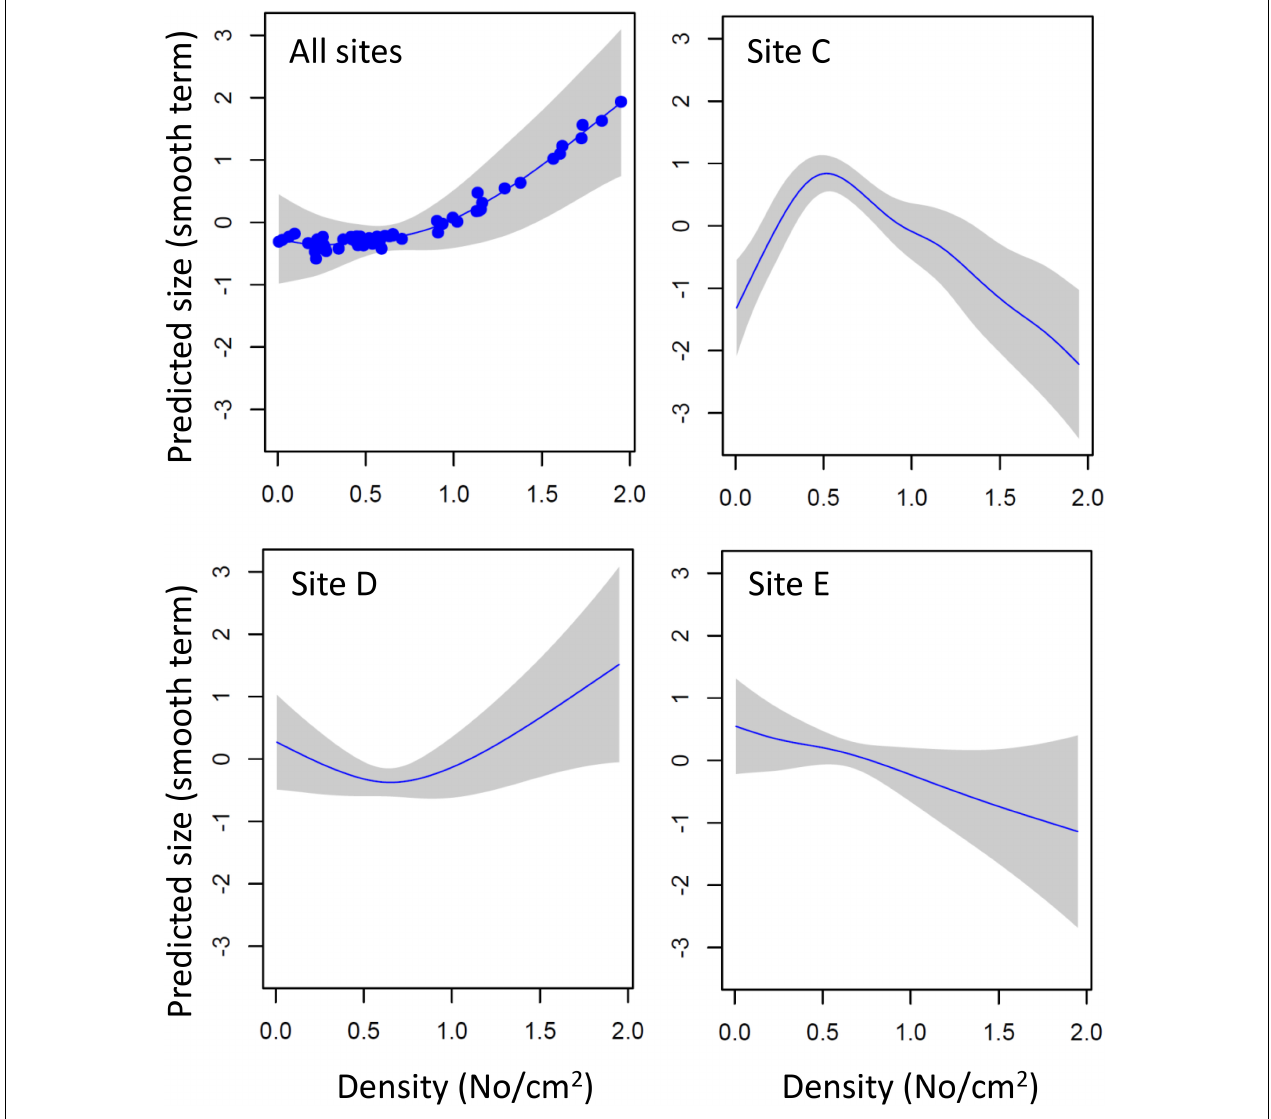
FIGURE 8 | Density-dependent changes in the growth of zebra mussel in different parts of Cardiff Bay. Shown are predicted sizes (GAM smoothed term centered around zero) and 95 CI envelopes across All sites , at sites with high recruitment (Sites C,E) and at a site of low recruitment (site D)